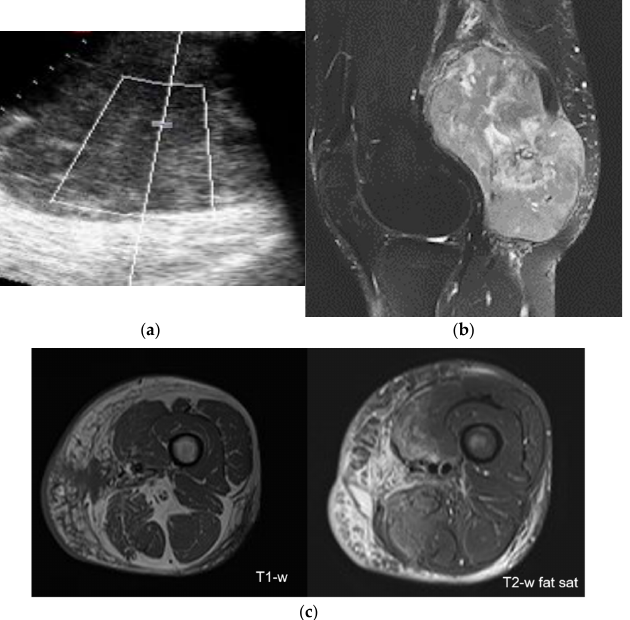
Figure 3. A 45-year-old man operated for a large MPNST with translocation t(X; 18) (p 11.2; q 11.2) and of genes SYT/SSX of the popliteal fossa shown by both US ( a ) and MRI ( b ). Follow-up did not show any changes consistent with relapse; only minor edema and fluid collection were present ( c ). Both MRI and US were reported negative for recurrence.